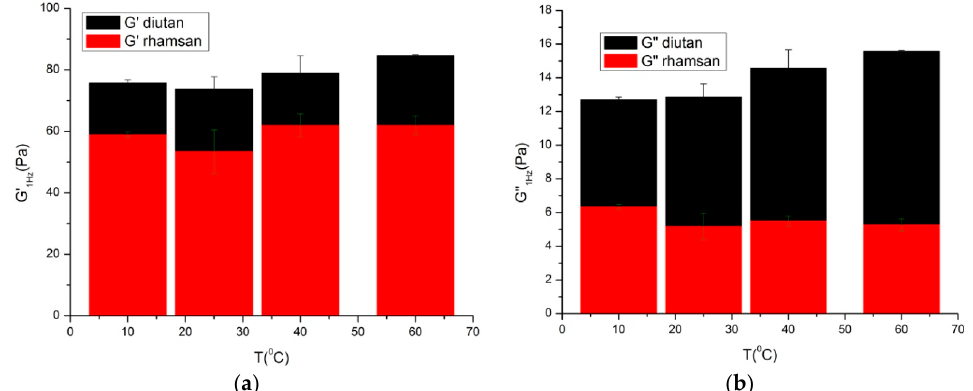
Figure 4. ( a ) Elastic module and ( b ) Viscous module, at 1 Hz, against temperature for 1 wt % diutan and rhamsan gum aqueous solutions. Additionally, standard deviation is plotted.